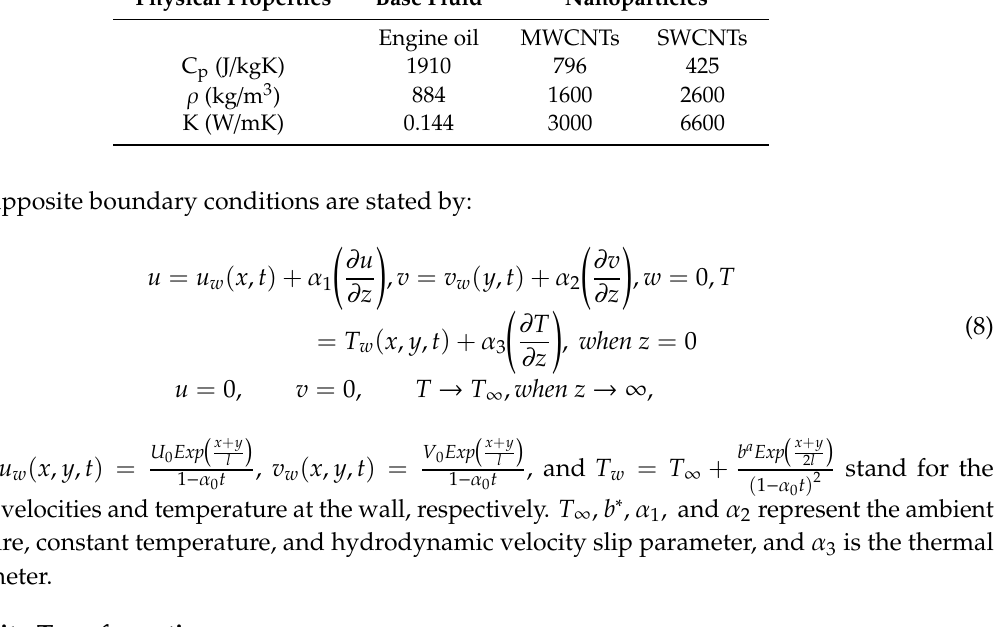
Table 1. Thermophysical attributes of the base fluid (engine oil), SWCNTs, and MWCNTs. Physical